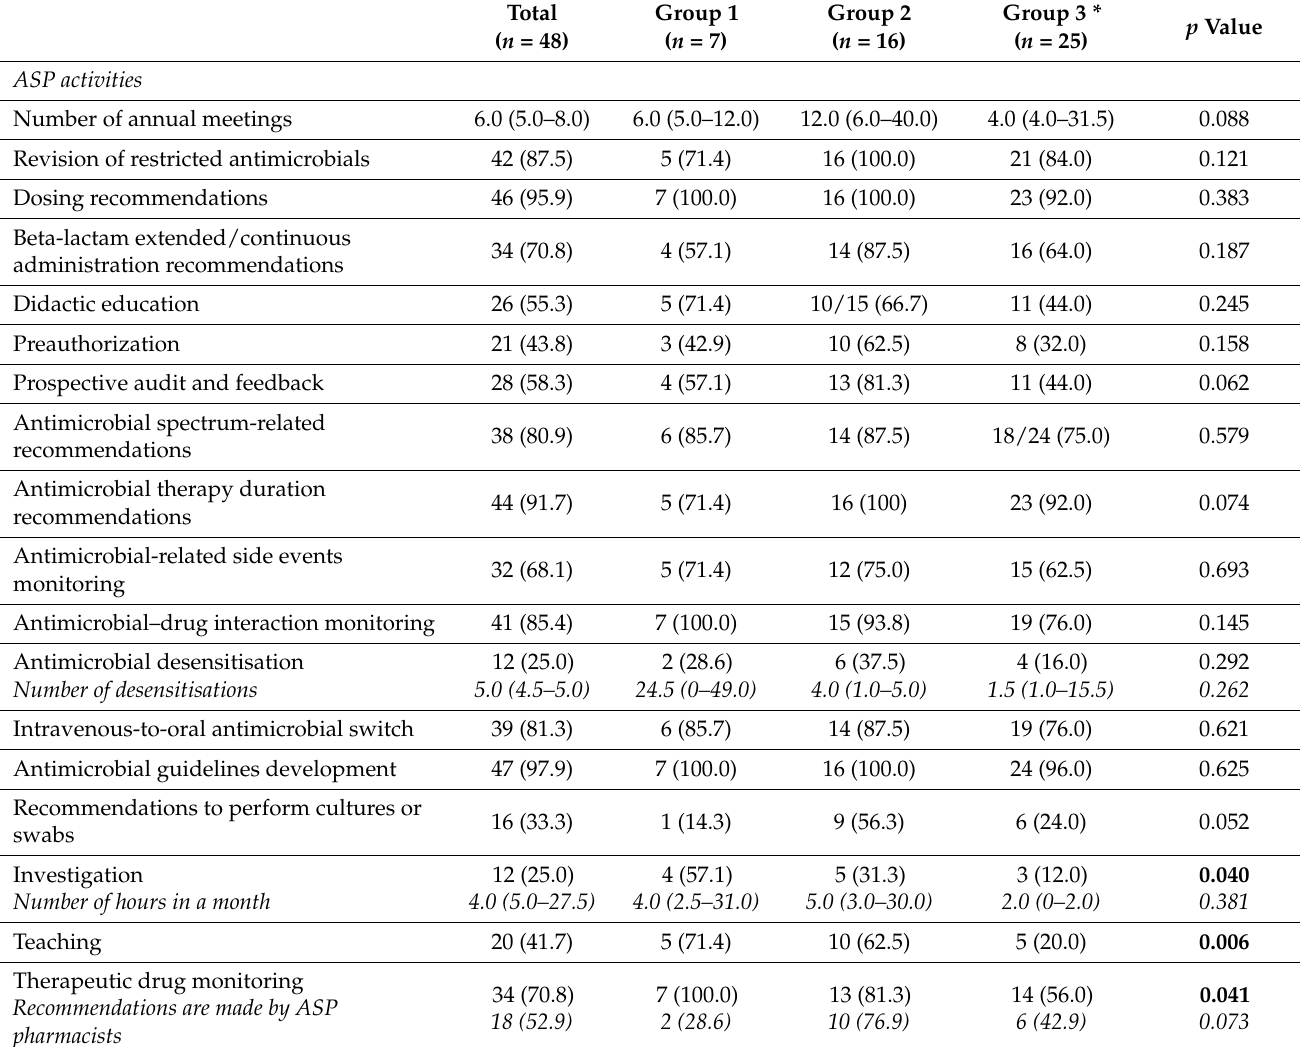
Table 2. Antimicrobial stewardship activities performed by clinical pharmacists according to the type of